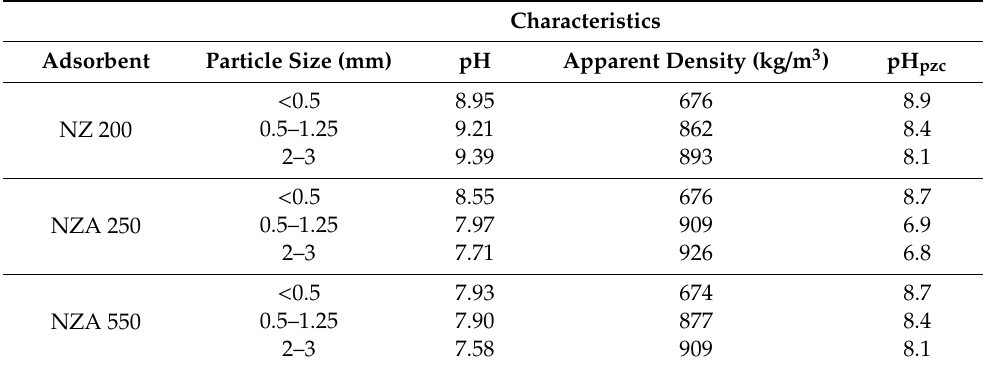
Table 2. Physical characteristics of NZ 200, NZA 250, and NZA 550 with di ff erent particle sizes.